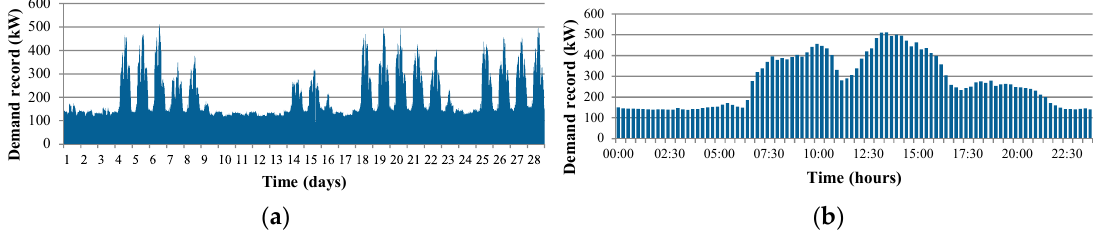
Figure 2. Demand records for: ( a ) one month and ( b ) one day.